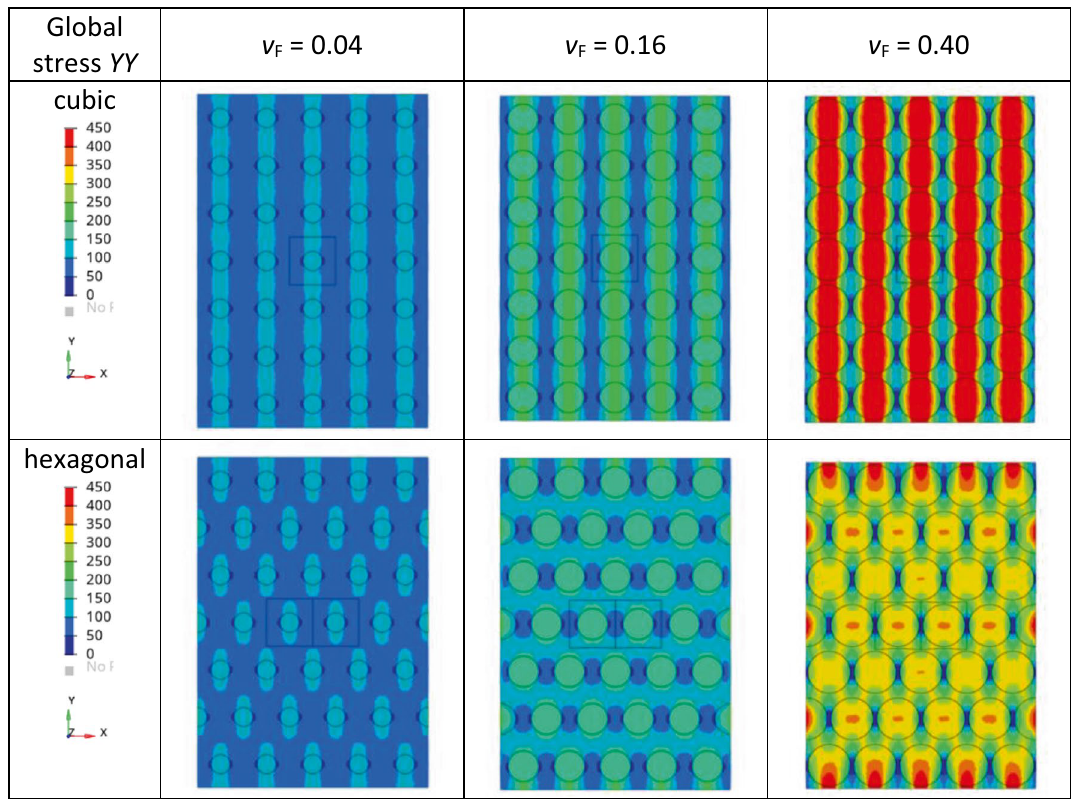
Figure 6. Filler content dependent stress distribution in tensile direction ( YY ) of cubic and hexagonal lattice arrangements of EV under tensile load in y -direction. Note that the displacements in y -direction are represented in a magnified manner. Filler content, v